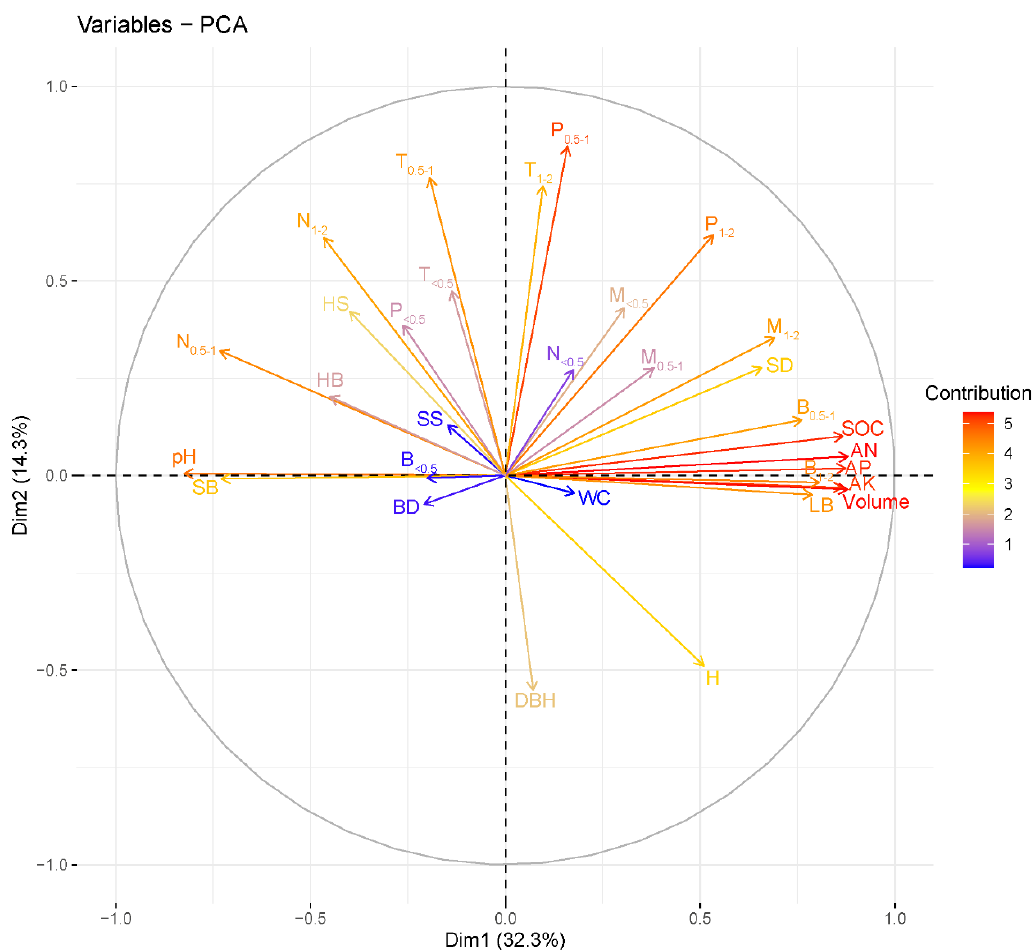
Figure 5. Principal component analysis of the entire soil profile among the fine-root characteristics, stand attributes and soil properties. The arrow of each variable represents the correlation coefficient between the variable and the first two principal components in the unit circle; the variables are colored by their contributions (%) to the variance in the principal component (see the corresponding eigenvalues and eigenvectors in Tables S2 and S3). AN, AP, AK, SOC, WC and BD: the available nitrogen, available phosphorus, available potassium, soil organic carbon, water content, and soil bulk density; DBH, H, SD, SS, HS, SB, HB, LB: diameter at breast height, tree height, stem density, shrub Shannon–Wiener index, herb Shannon–Wiener index, shrub biomass, herb biomass, and litter biomass; P <0.5 , P 0.5–1 , and P 1–2 : <0.5, 0.5–1, and 1–2 mm fine-root production; M <0.5 , M 0.5–1 , and M 1–2 :